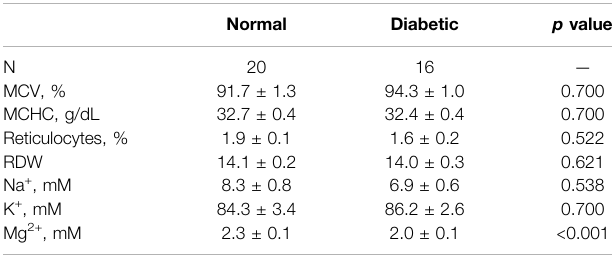
Mean cellular volume (MCV); mean corpuscular hemoglobin concentration (MCHC); red celldensitywidth(RDW);totalcellularNa + ;K + andMg 2+ weredeterminedasdescribedin Methods. p values were determined by unpaired Mann-Whitney